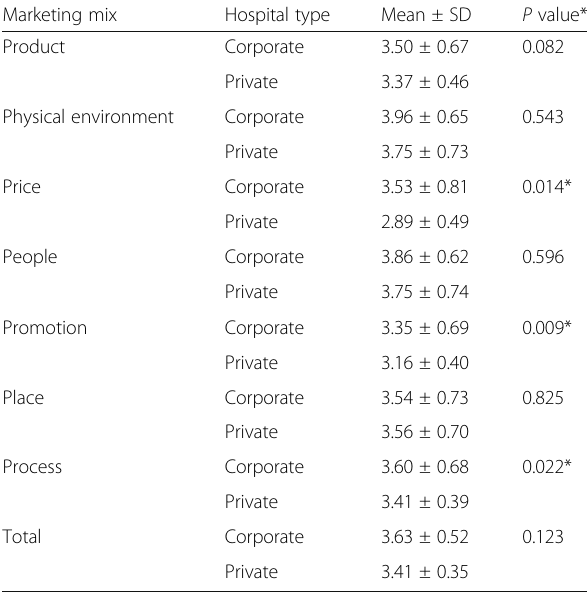
Table 3 The relationship between marketing mix and hospital type (private/corporate hospital), Shiraz, Iran Marketing mix